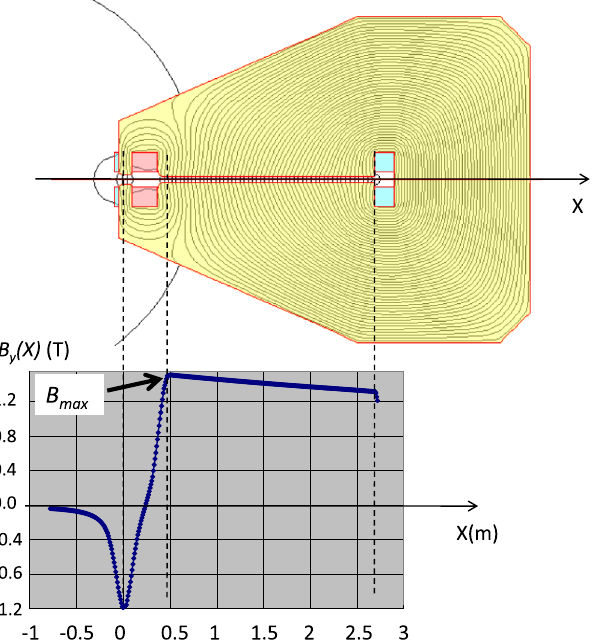
FIG. 5. Cross section of the bending magnet with gradient and reversed field strip and B y ð X Þ , where B density in the field distribution.